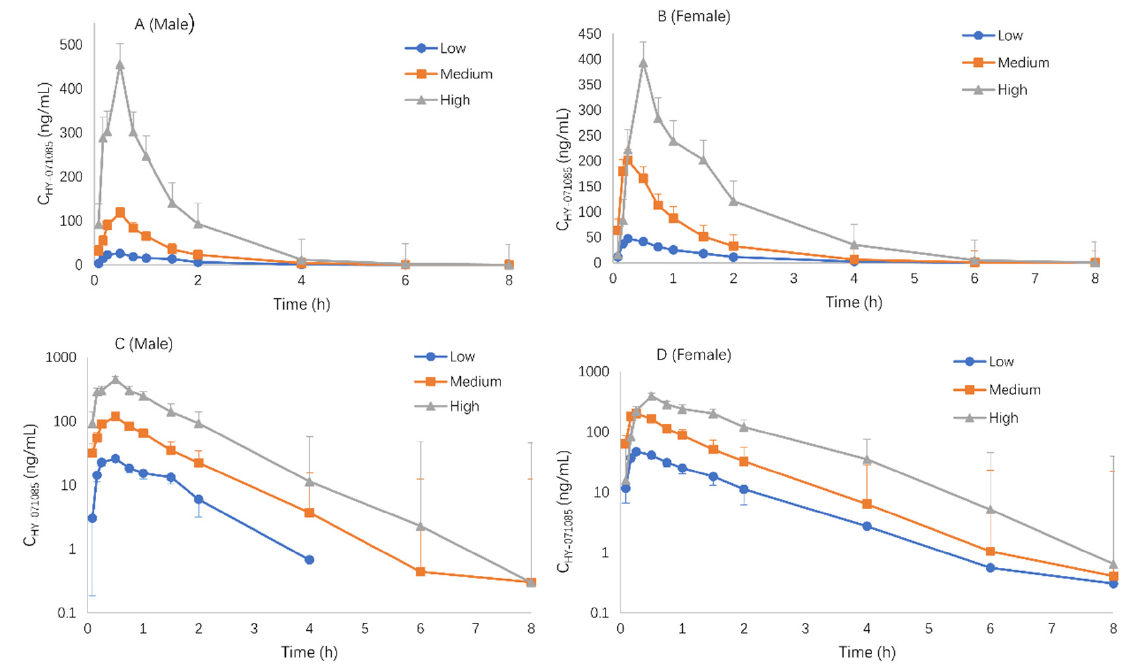
Figure 7. Mean plasma concentration–time curve of HY-071085 after the single-dose intragastric administration of HY-071085 at low (1.25 mg/kg), medium (2.5 mg/kg) and high (5 mg/kg) doses in beagle dogs. ( A ) Constant coordinates; ( B ) semilogarithmic coordinates.